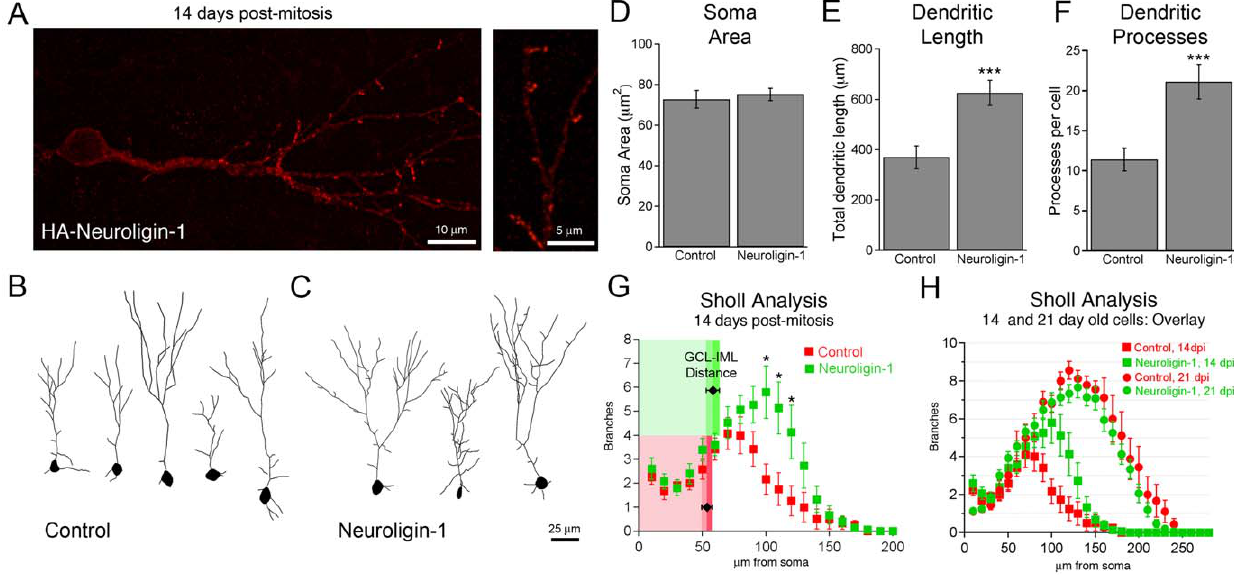
Figure 7. Neuroligin-1 overexpression transiently increases dendritic process number. A. HA-neuroligin-1 expression pattern in 14-day- old adult-born granule cells, visualized with anti-HA staining. Exogenous neuroligin-1 is expressed throughout the dendritic tree (left; scale bar, 10 m m.) and is concentrated along filopodium-like protrusions from the dendritic shaft (right; scale bar: 5 m m). B, C. Dendritic tree morphology of representative 14-day-old neurons shows an increased number of processes along the dendritic tree of neuroligin-1 overexpressing cells. Scale bar: 25 m m. D, E, F. Summary data for 14 day old neurons shows no difference in cell soma size, but a neuroligin-1 mediated increase in total dendritic length and dendritic process number (shown 6 SEM, control, n=12 cells; NLG-1, n=11 cells; *** p , 0.005). G. Dendritic branch (Sholl) analysis demonstrates increased branching along more distal dendrites in neuroligin-1 overexpressing 14-day-old cells (* p , 0. 01, two way repeated measures ANOVA). The shaded areas correspond to the average distance from each soma to the granule cell layer (GCL)-inner molecular layer (IML) border in the two groups (n.s.). H. Overlay of Sholl analyses from 14 and 21 day old neurons. Between 14 and 21 days, granule cell dendrites grow to span the full width of the dentate molecular layer and basal dendrites (10–20 m m from soma) retract.